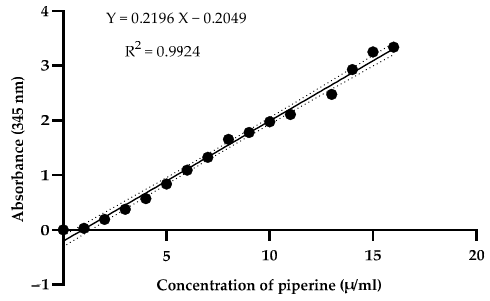
Figure 2. The standard curve of piperine by UV spectrophotometry.